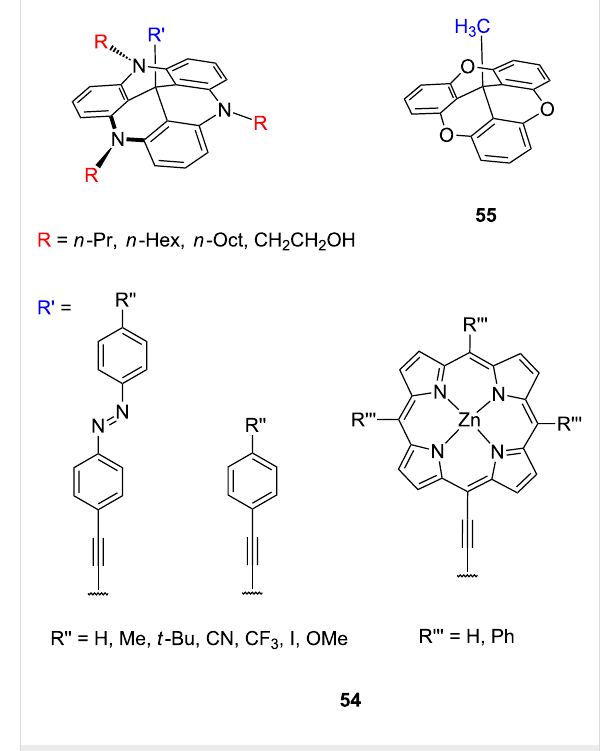
Figure 30: Structure of triazatriangulenium 54 and trioxatriangulenium 55